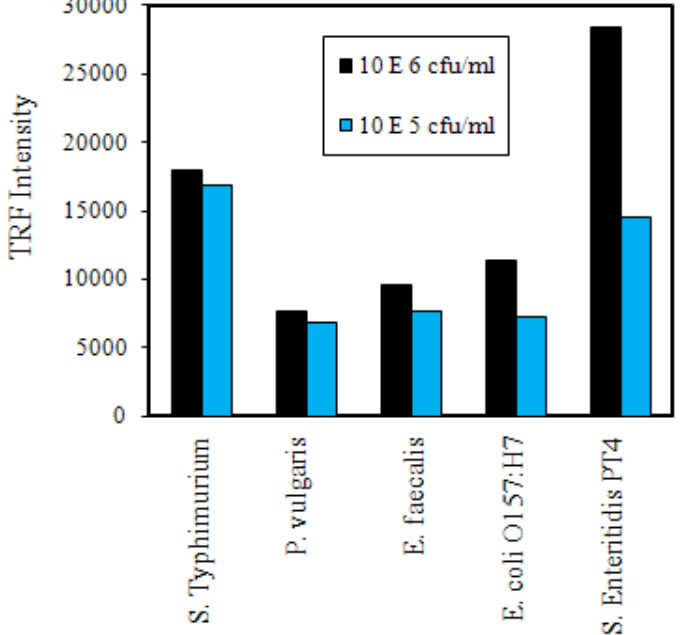
Figure 4. Selectivity tests of immunomagnetic bead time-resolved immunofluorescence (IMB-TRF). Values are from an average of two wells each tested with two different concentrations of